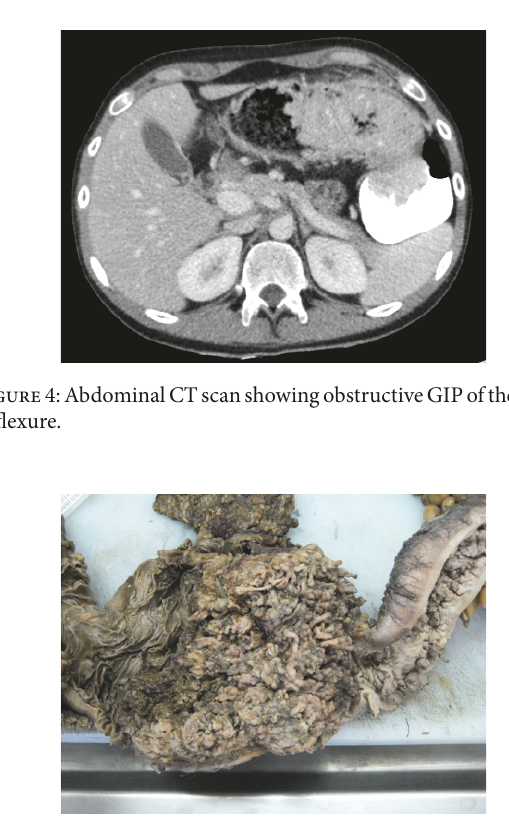
Figure 5: Surgical resection of